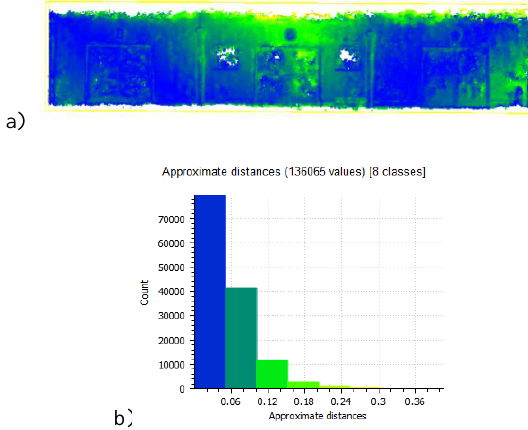
Figure 12. Accuracy assessment of a point cloud generated from video frames with a 60% overlap, with reference to TLS